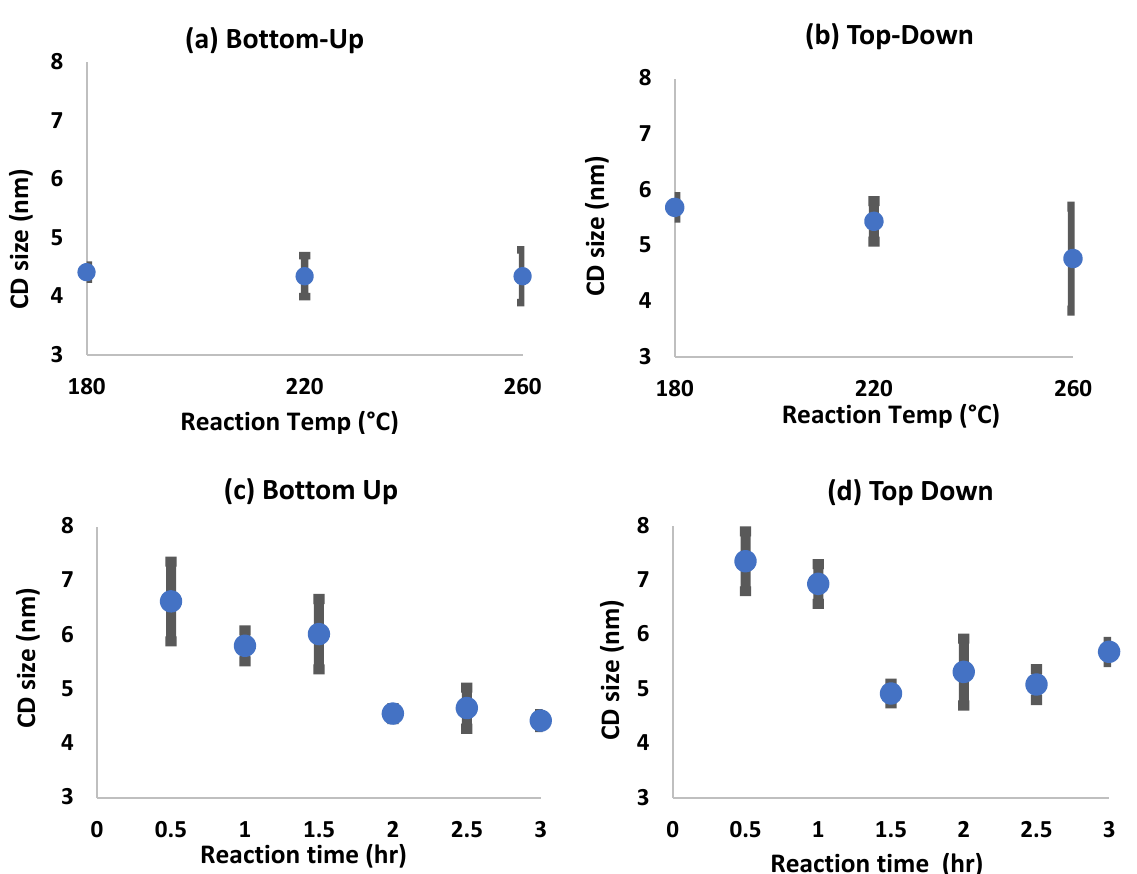
Figure 3. Size distributions per HTC condition for bottom-up and top-down CD synthesis. Grey bars indicate distribution, blue markers indicate average sizing. All sizes s reported in nm. ( a ) Size distribution at 3.0 h and varying temperatures for bottom-up synthesis. ( b ) Size distribution at 3.0 h and varying temperatures for top-down synthesis. ( c ) Size distribution at 180 °C and residence times for bottom-up synthesis. ( d ) Size distribution at 180 °C and residence times for top-down synthesis.